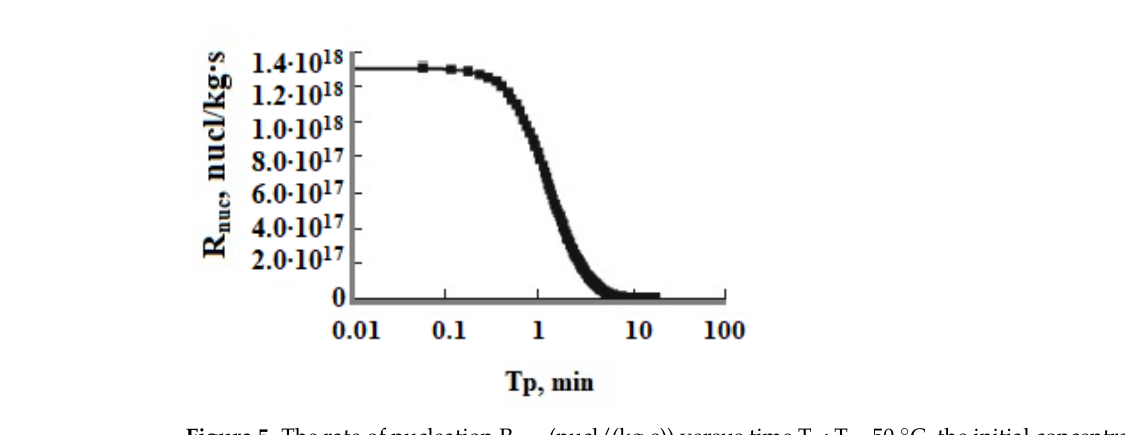
Figure 4. The number of new particles PNS (nucl/kg) versus time Т p; T = 50 °C, the initial concen- tration is C s = 700 mg/kg, рН = 8.